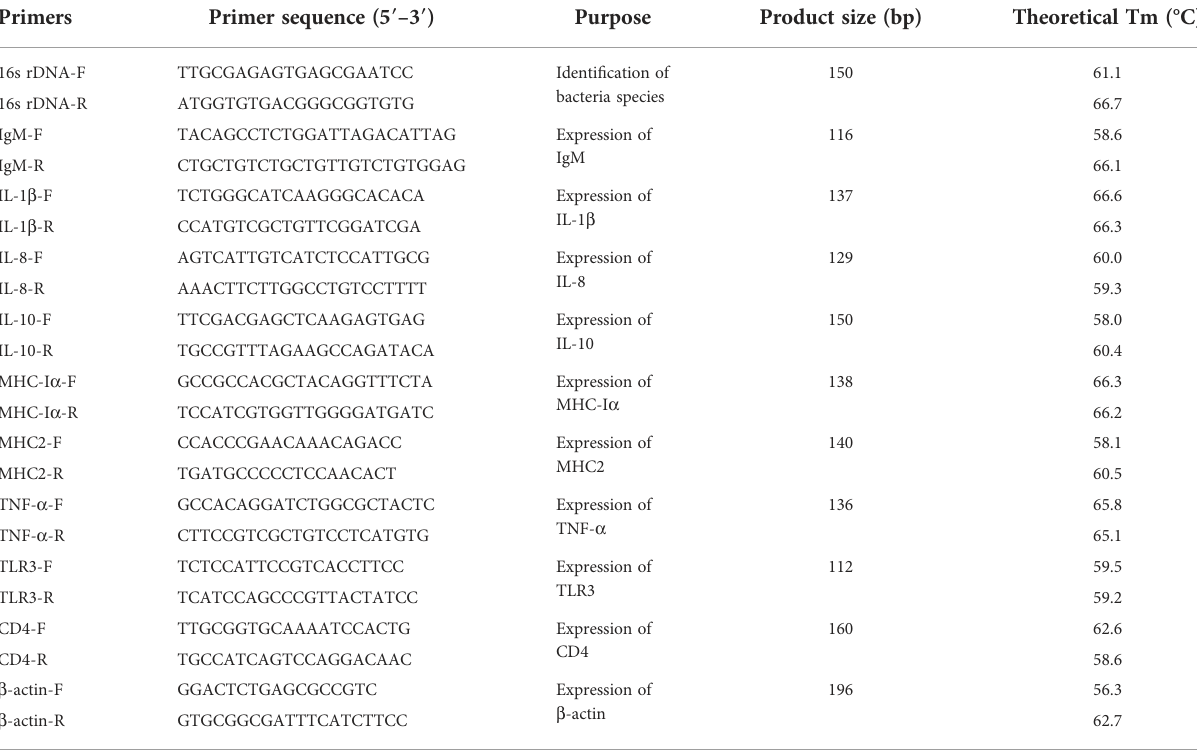
TABLE 1 Primers used in this study.